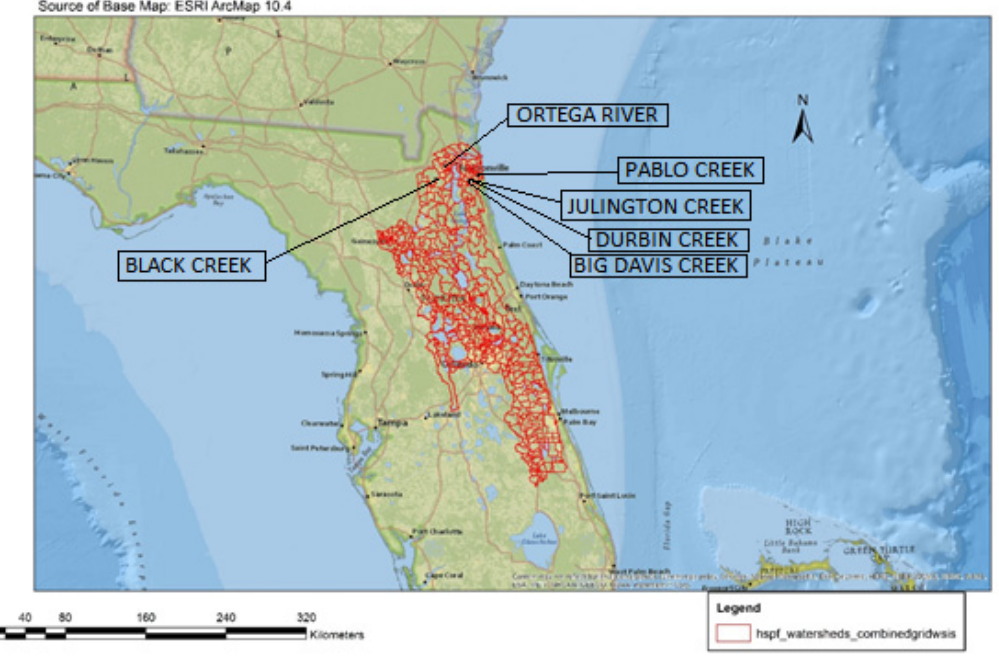
Figure 1. Project study area covering the St. Johns River watershed in Florida, USA.